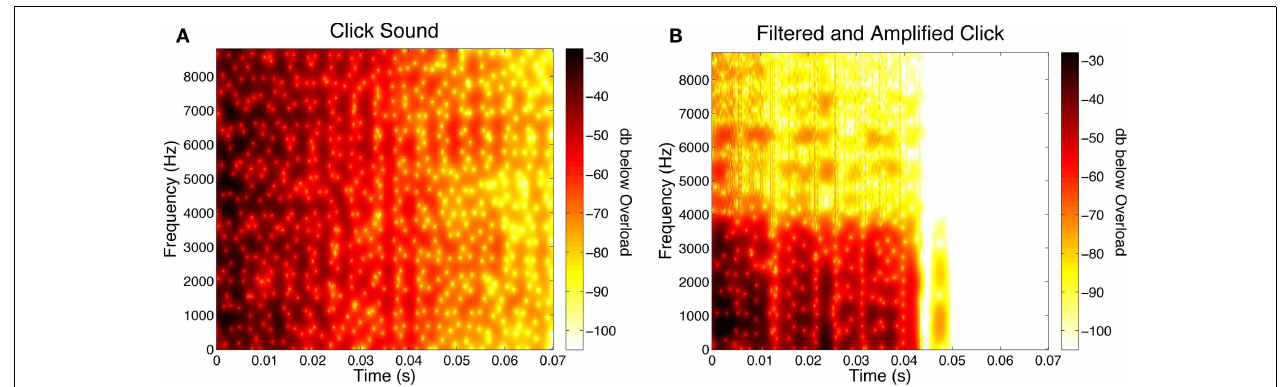
spectrum, but gradually diminishes over time. ( B) Spectrogram of a click used in ExperimentThree.The spectrogram shown is for the age-sensitive, filtered click that has been amplified to match the loudness of the unfiltered click. Note that early on, high amplitude is seen only at the lowest frequencies. Notice also, that above ∼ 3kHz, amplitudes are less than at the corresponding frequencies in the unfiltered click.